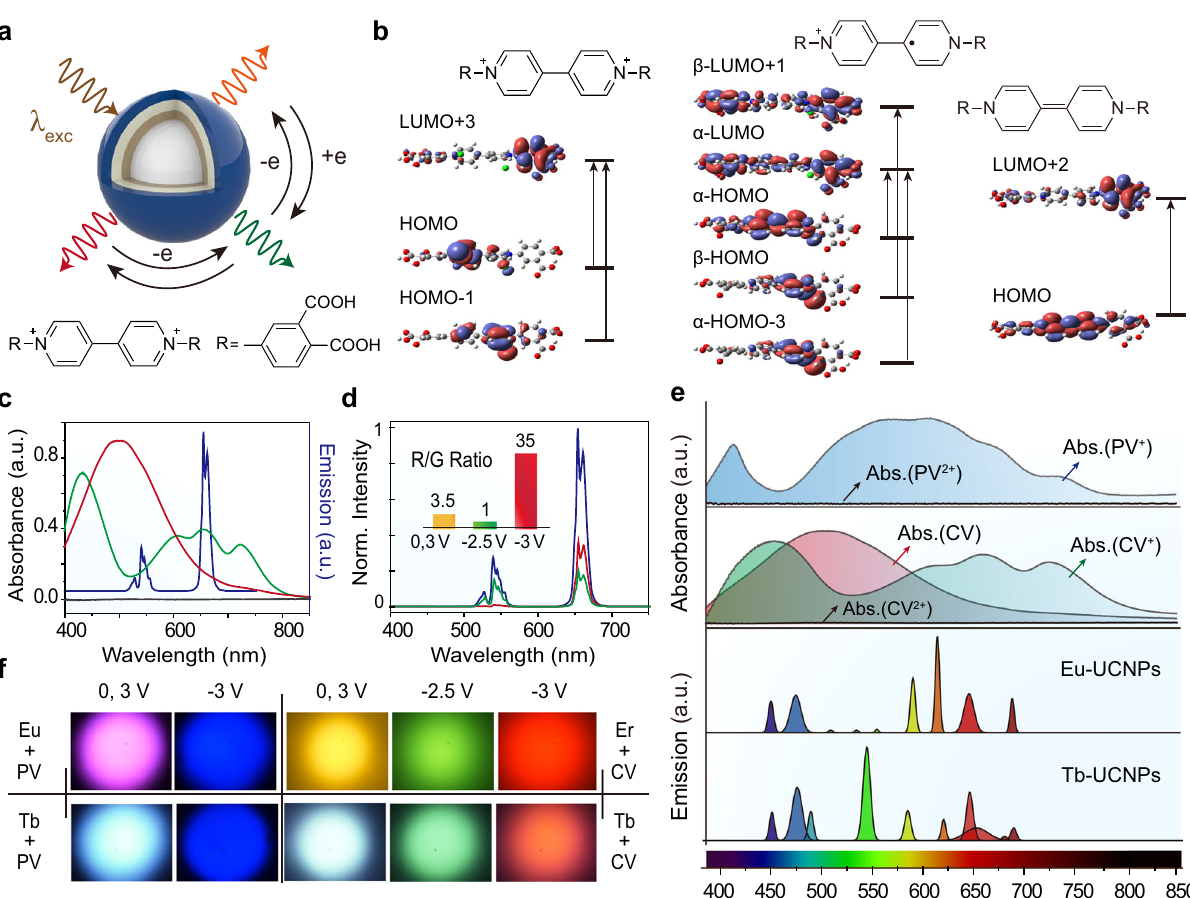
Fig. 3 Multicolour luminescence switching of UCNPs through opto-electrochemical modulation. a Schematic showing achievement of electrically multicolour switching using UCNPs modi fi ed with 1,1 ’ -bis(3,4-dicarboxyphenyl)-4,4 ’ -bipyridinium dichloride (CV) molecules. b DFT-calculated molecular orbital diagrams and dominant absorption transitions of 1,1 ’ -bis(3,4-dicarboxyphenyl)-4,4 ’ -bipyridinium dichloride molecule in three reduced and oxidised states. c Emission spectrum (blue) of the hybrid fi lm and absorption spectra of CV molecules in the oxidised state (black), fi rst reduced state (green), and second reduced state (red). d Emission spectra of the hybrid fi lm under different potentials. Inset shows the red/green intensity ratios obtained under different potentials. e Absorption spectra of as-designed viologen molecules (PV and CV) in several reduced and oxidised states and deconvolution of emission spectra of two typical UCNPs (NaGdF 4 :Yb/Tm@NaYF 4 :Eu and NaGdF 4 :Yb/Tm@NaYF 4 :Tb) into individual Gaussian peaks. f Upconversion multicolour switching of a wide variety of UCNP/Viologen systems under different